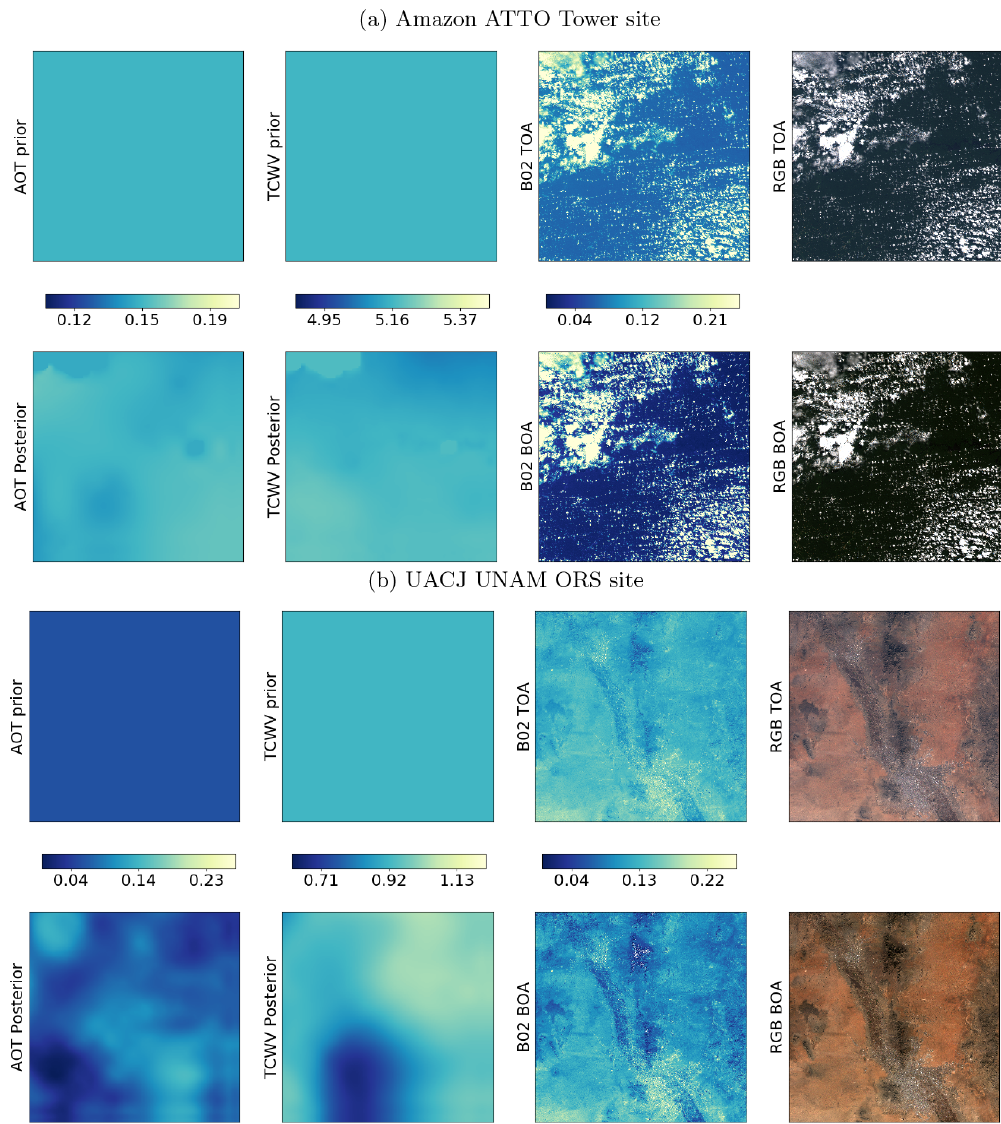
Figure F2. Example of retrieval on S2 data over (a) Amazon ATTO Tower site (S2 Tile 21MTT, 27 June 2019, top row) and (b) UACJ UNAM OR site (S2 tile 13SCR, 14 January 2019, bottom row). Top row of each panel, left to right: AOT prior mean from CAMS, TCWV prior mean from CAMS, blue band TOA reflectance, TOA RGB composite. Bottom row of each panel, left to right: a posteriori AOT mean, a posteriori TCWV mean, blue band BOA reflectance, BOA RGB